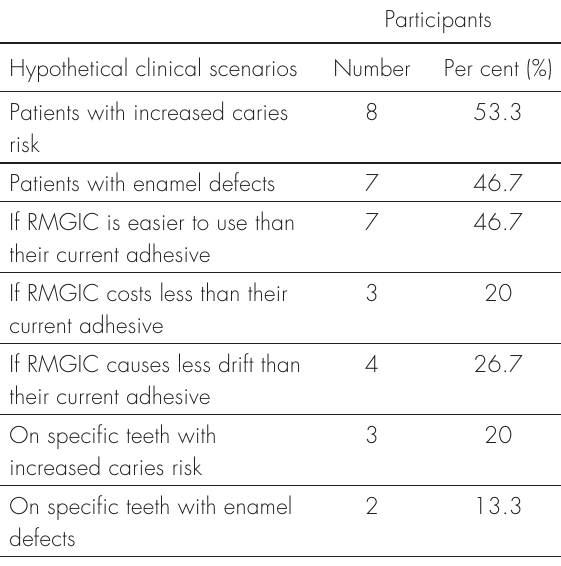
Table IV. Suggested hypothetical clinical scenarios, and frequency of these scenarios being chosen, by practitioners, for the use of RMGIC bracket bonding